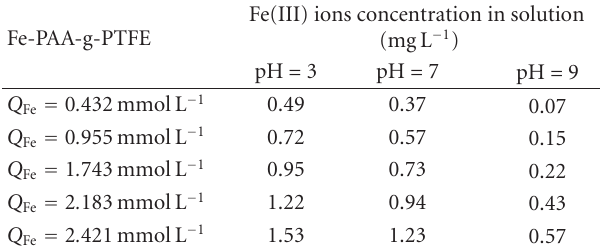
Table 2: Leaching of Fe ions from Fe-PAA-g-PTFE with di ff erent Q Fe values.